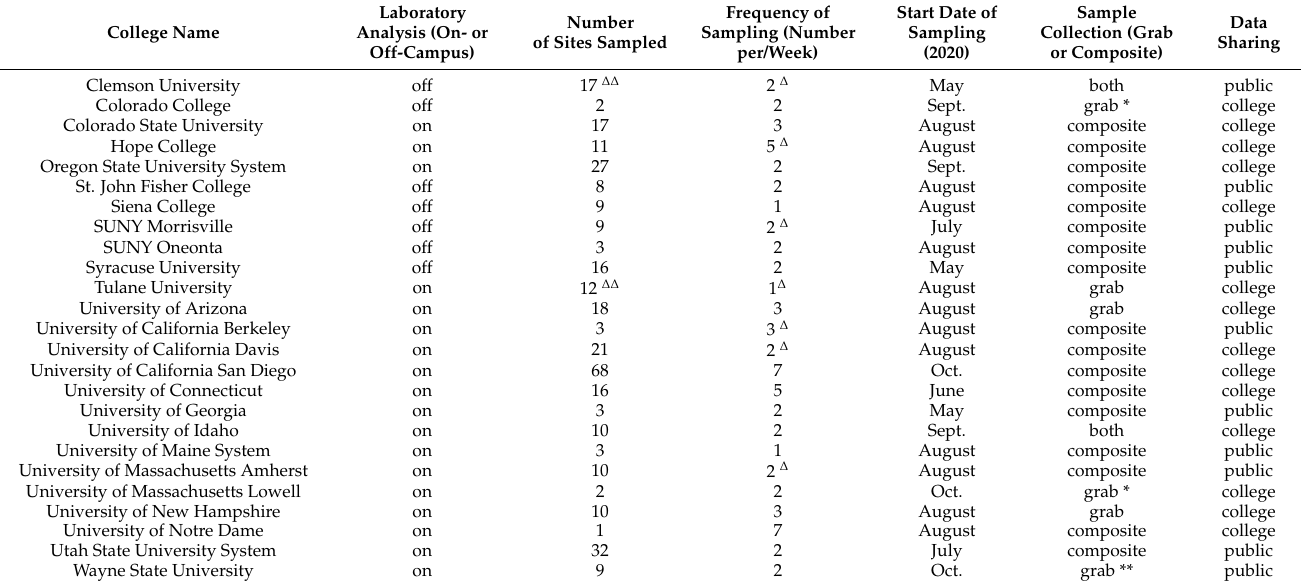
Table 2. Characteristics of college wastewater monitoring programs.